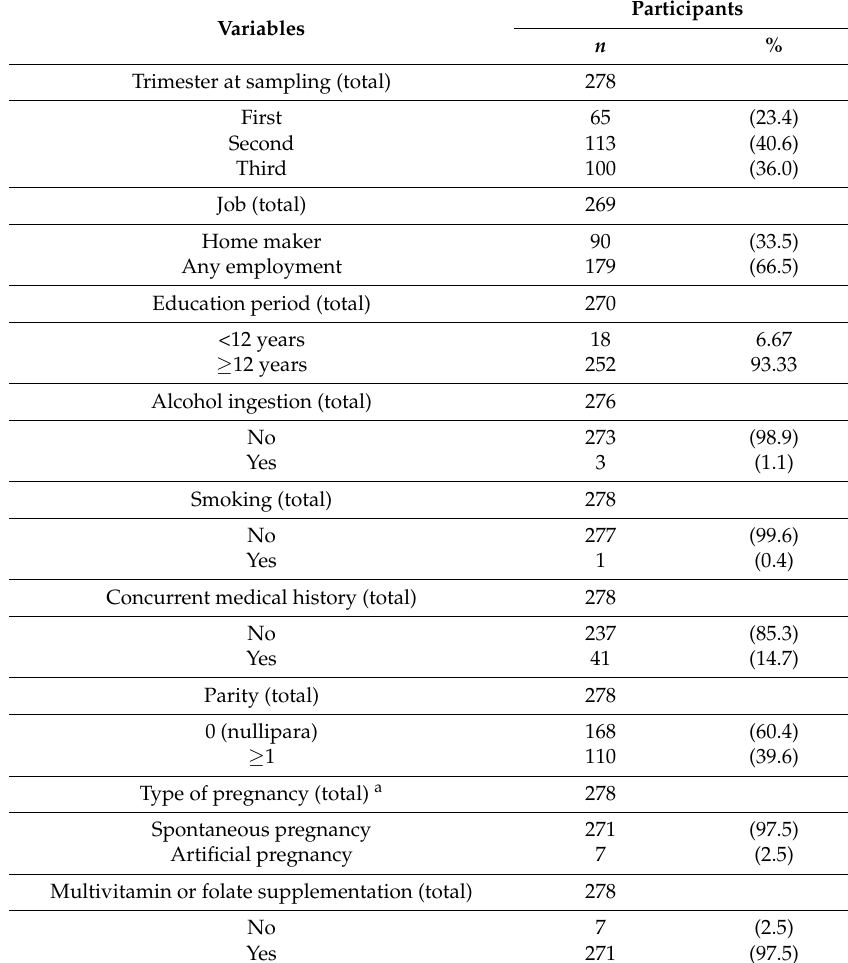
Table 1. Demographic characteristics and pregnancy outcomes of the sample of 278 Korean pregnant